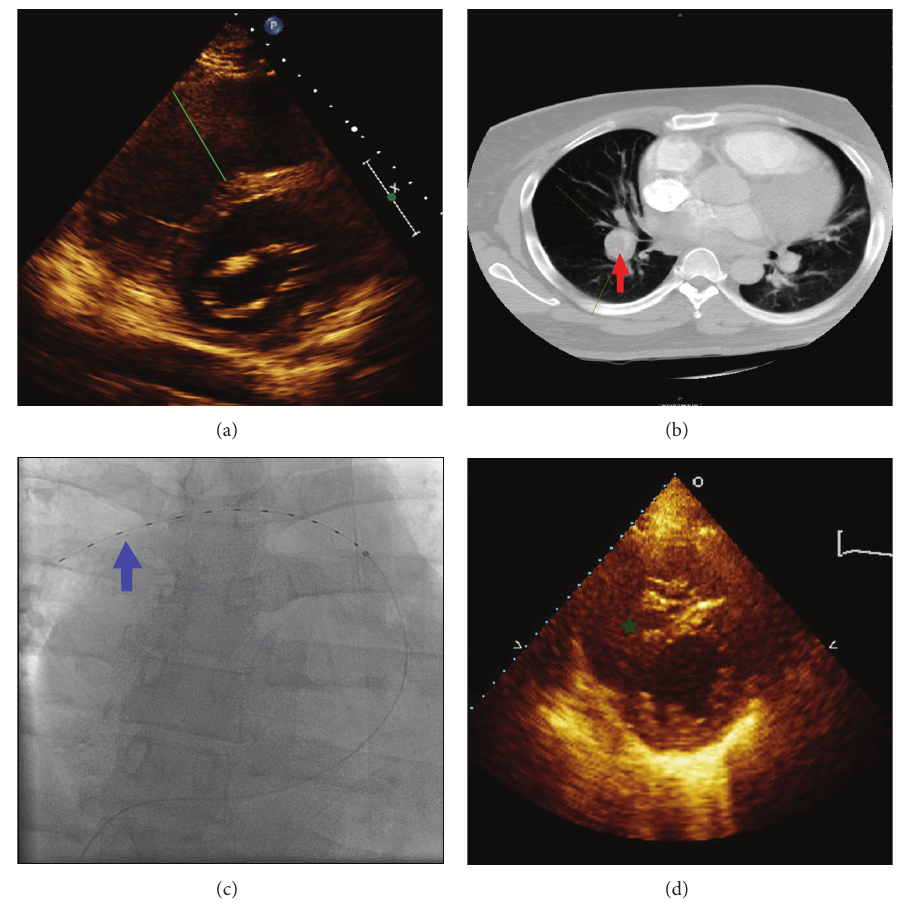
Figure 1: (a) The parasternal short axis view from echocardiography shows dilatation of the right ventricle (green line). (b) The CT-thorax with contrast filling defect in the right main pulmonary artery confirms the diagnosis of pulmonary embolism. (c) The fluoroscopy illustrates the placement of ultrasound-accelerated thrombolysis catheter in the right main pulmonary artery. (d) The improvement in right ventricular function after UAT (green